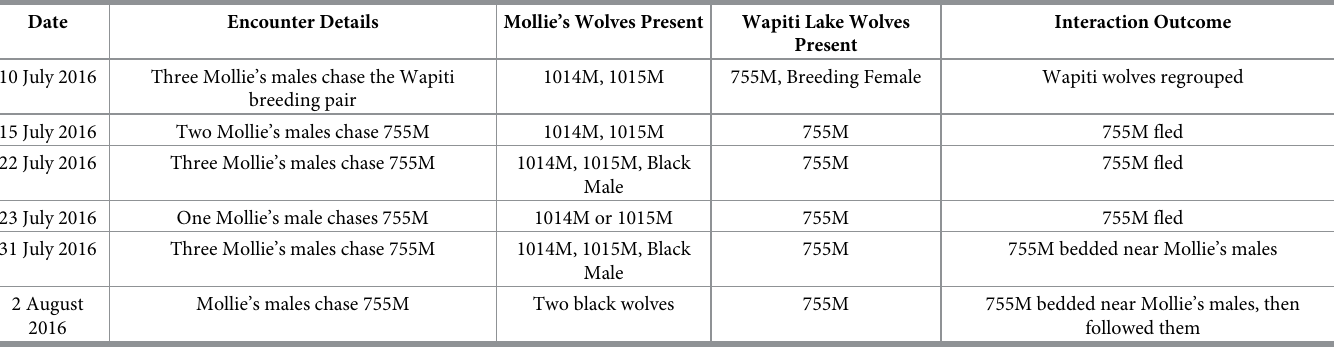
Table 2. Aggressive encounters between 755M and the intruding male from the Mollie’s